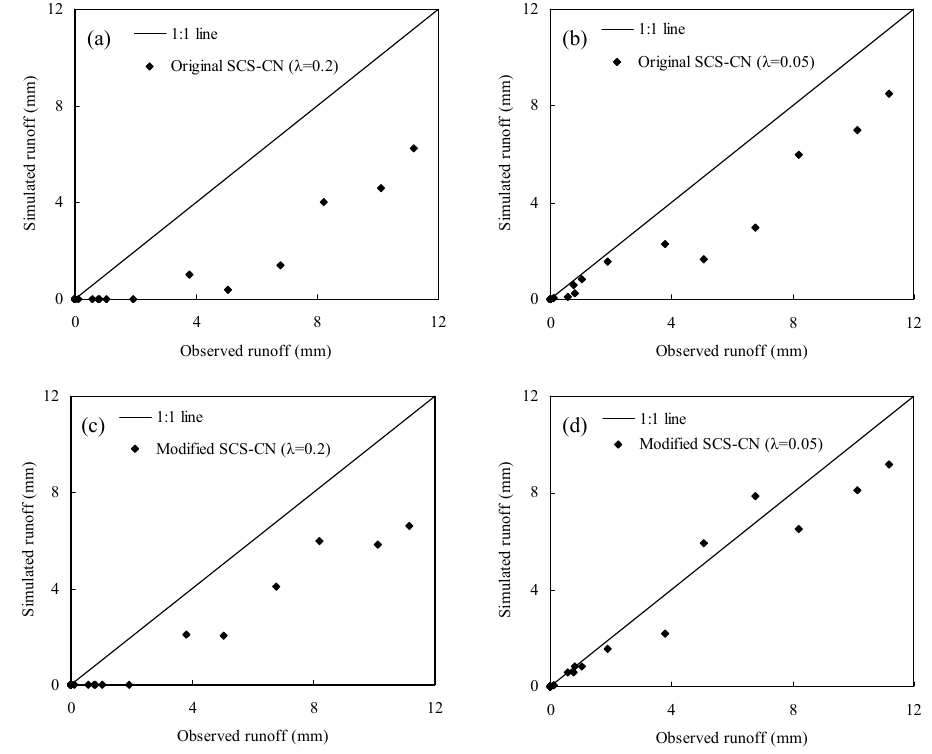
Fig. 3. Comparison between observed and predicted event runoff using (a) original SCS-CN ( λ = 0 . 2), (b) original SCS-CN ( λ = 0 . 05), (c) modified SCS-CN ( λ = 0 . 2) and (d) modified SCS-CN ( λ = 0 . 05) models for Group 1 runoff plots